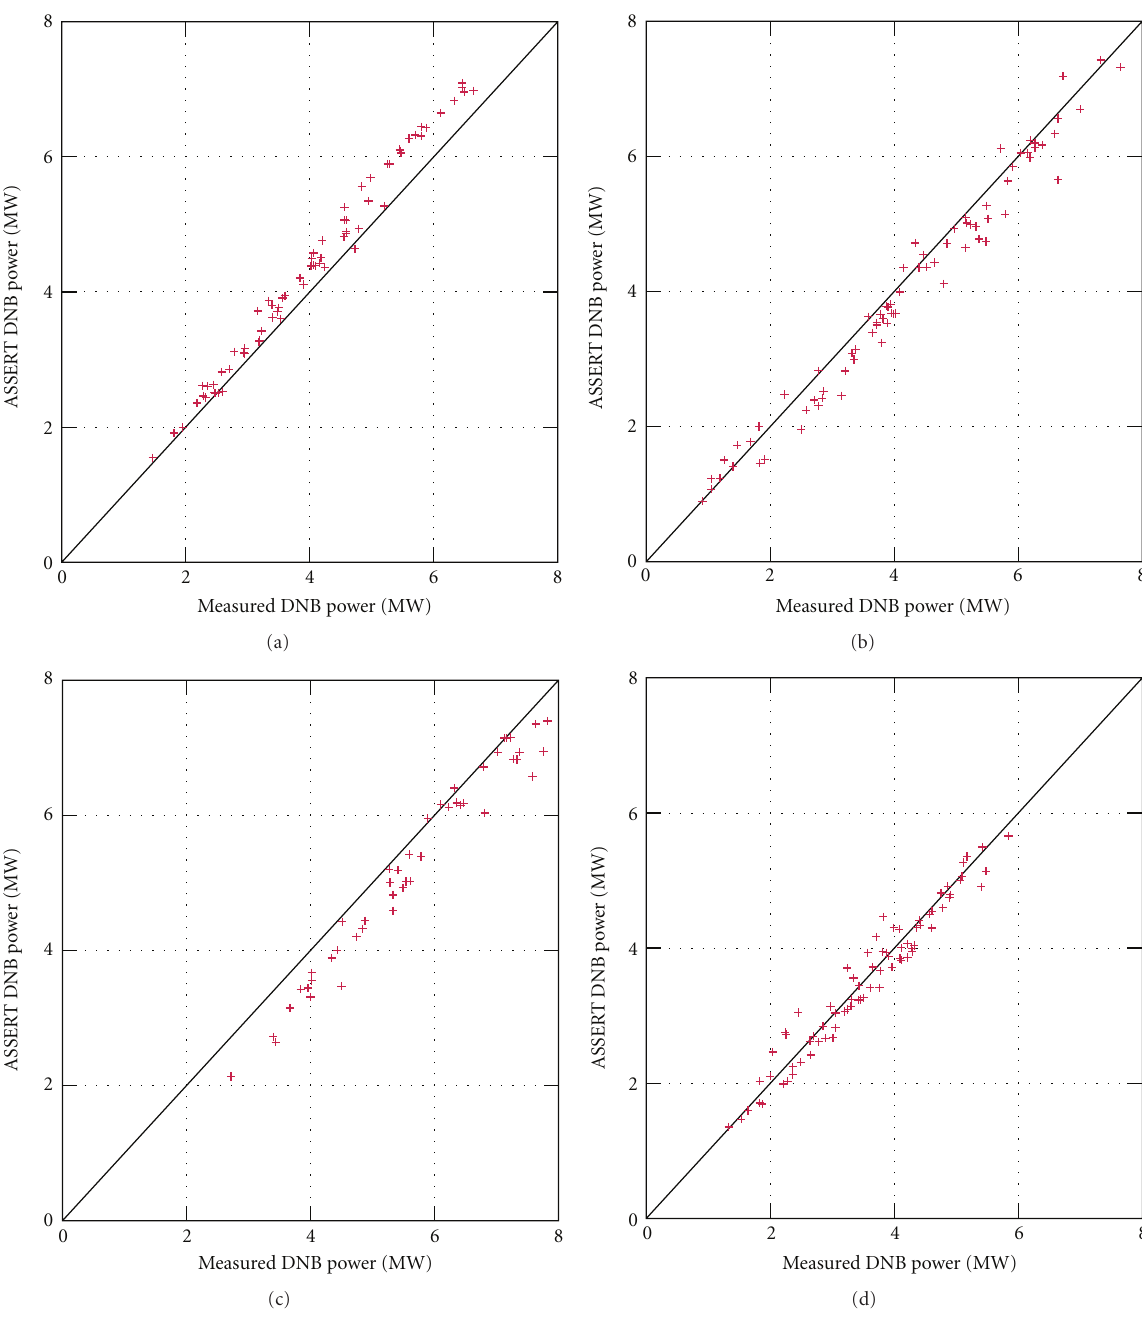
Figure 16: Steady state departure from nucleate boiling results for test series A0 (a), A2 (b), A3 (c), and A4 (d). The estimated uncertainty on the power measurements is 2 σ exp = 2% and is not illustrated in the figure. Table 6: Accuracy of steady state isolated subchannel void fraction predictions. The value of 1 σ is estimated to be ± 0 . 03. Geometry N Points Number of points where | (cid:2) α | ≤ ± σ exp (percent) Number of points where | (cid:2) α | ≤ ± 2 σ exp